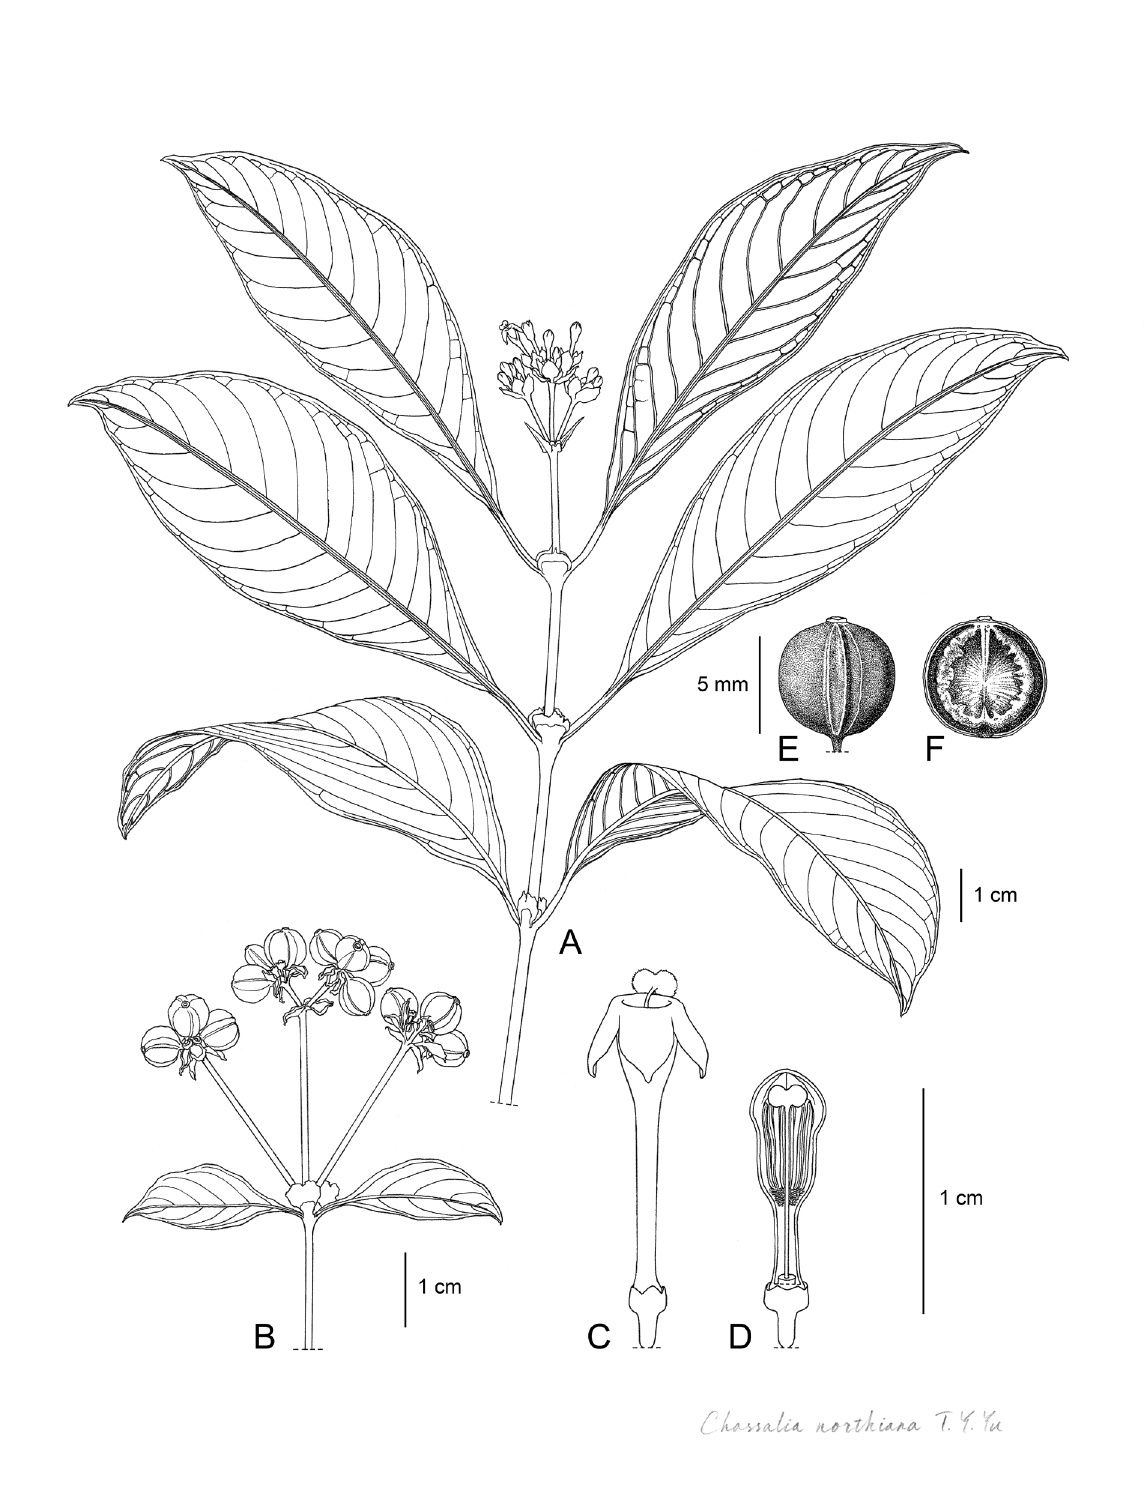
Fig. 28. Chassalia northiana T.Y.Yu sp. nov. A . Flowering shoot. B . Infructescences. C . Flower. D . Longitudinal view of corolla in bud showing stamens, band of hairs, stigma, style, disc, calyx and hypanthium. E . Dry fruit. F . Pyrene ventral surface. A, C–D from Bernard Lee Meng Hock S 53828 ; B, E–F from Munting & Jugah S 55620 . Drawn by T.Y.